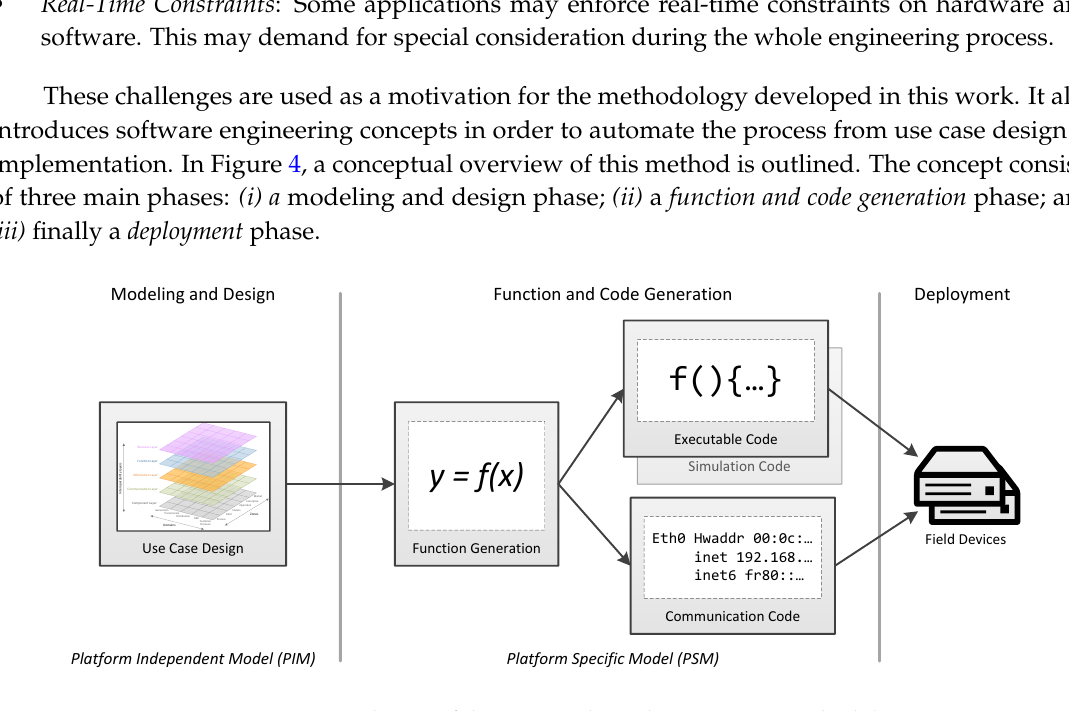
Figure 4. Conceptual view of the proposed rapid engineering